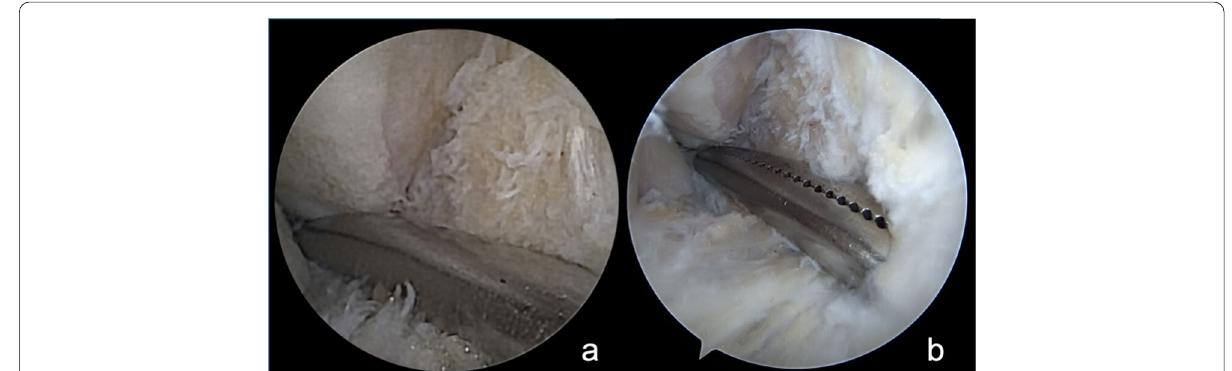
Fig. 4 Halstead forceps in the lateral talar gutter. A NanoScopeTM view. B Standard arthroscope view